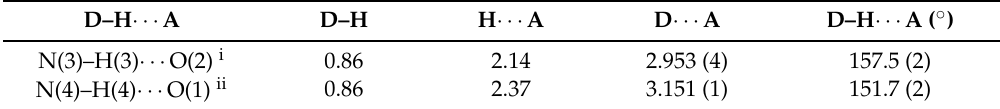
Table 5. Intermolecular hydrogen bonds for compound 3 (Å, ˝ ).